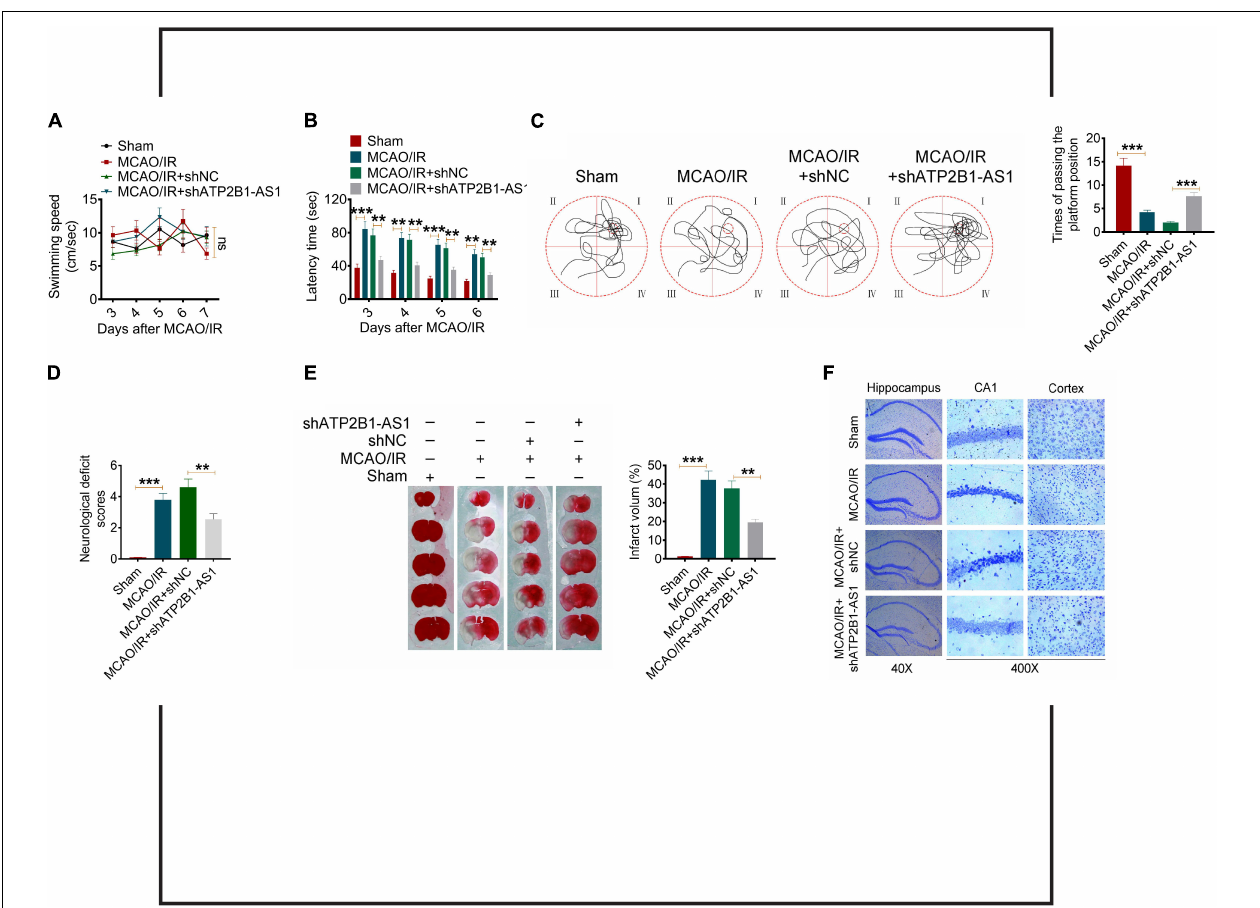
FIGURE 8 | Effect of ATP2B1-AS1 on the neurological function of MCAO/IR rats. A Morris water maze test was performed to evaluate the memory deficits and nerve damage of MCAO/IR rats. (A) The swimming speed of all the groups of rats. (B) Knockdown of ATP2B1-AS1 decreased the latency time of MCAO/IR rats. (C) Knockdown of ATP2B1-AS1 increased the time of passing the platform position of MCAO/IR rats. (D–F) Knockdown of ATP2B1-AS1 decreased the neurological deficit scores (D) , reduced the cerebral infarct volume (E) , and reduced the number of damaged neurons (F) of MCAO/IR rats. * P < 0.05, ** P < 0.01, *** P <